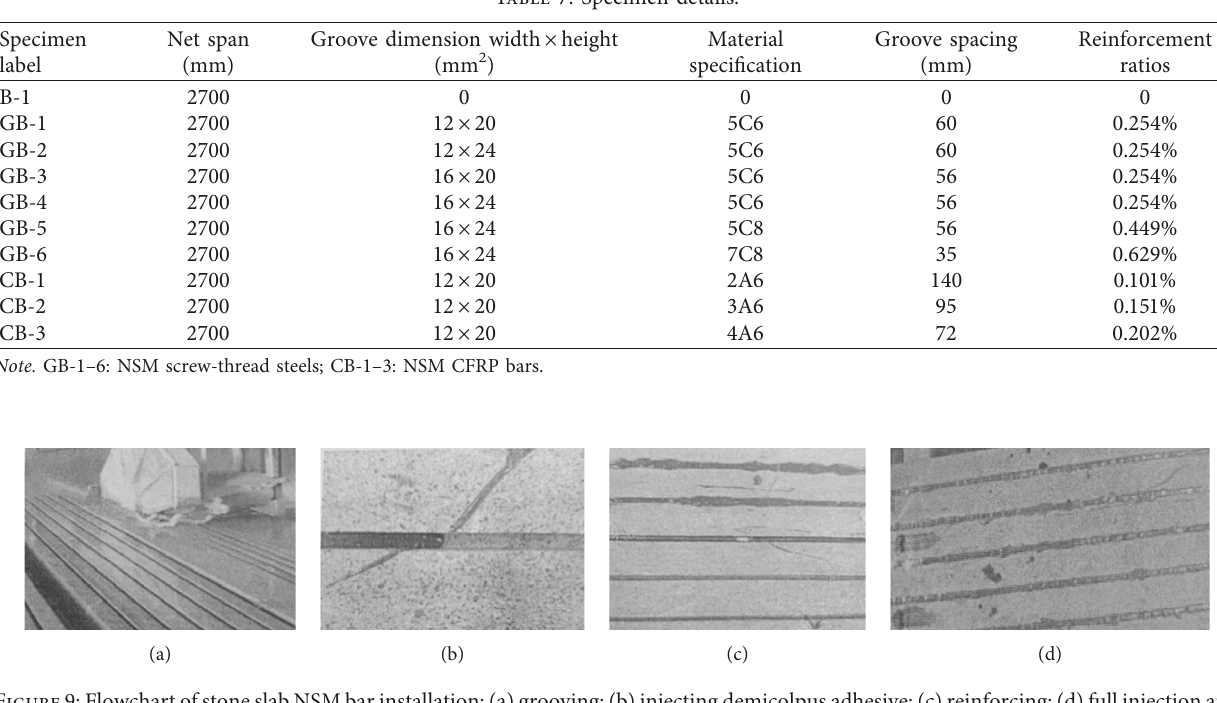
Figure 9: Flowchart of stone slab NSM bar installation: (a) grooving; (b) injecting demicolpus adhesive; (c) reinforcing; (d) full injection and curing.